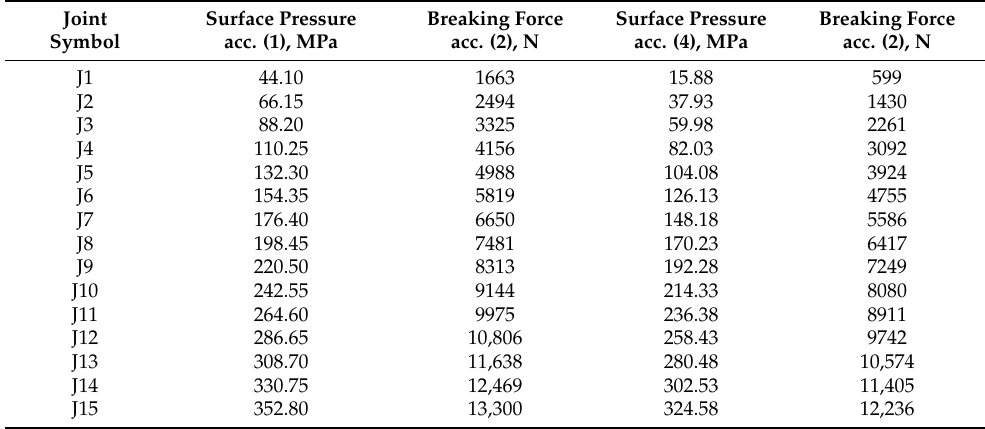
Table 2. Results of calculations of surface pressures and breaking forces based on classic and modified Lame’s formulas.